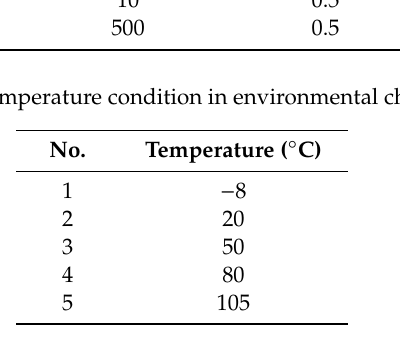
Table 1. Profile of harmonic excitation. Table 2. Temperature condition in environmental chamber.